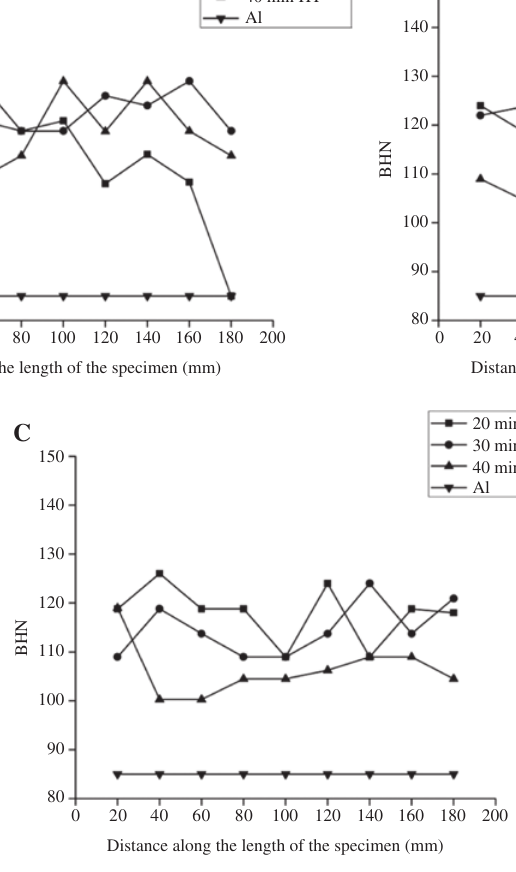
with constant AT of (A) 10 min, (B) 20 min, and (C) 30 2